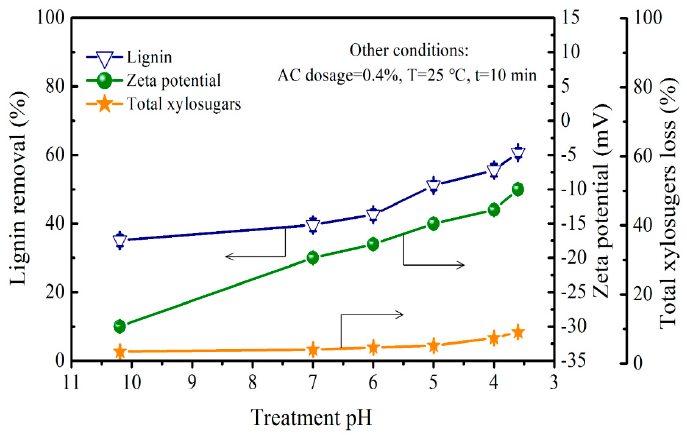
Figure 4. Influence of treatment pH on the lignin removal, total xylosugars loss, and zeta potential of AC.